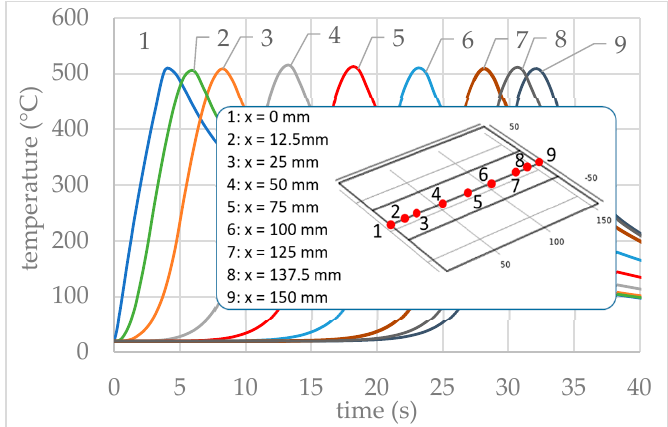
Figure 5. Thermal cycles in the probes (1–9), (T510V5).